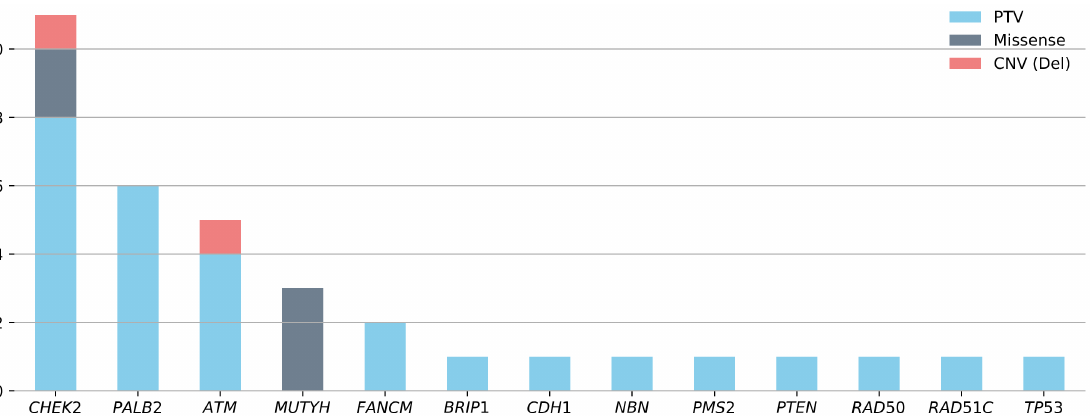
Figure 1. Gene-specific prevalence of heterozygous pathogenic germline variants (PVs) in 340 patients with BRCA1/2 -negative male breast